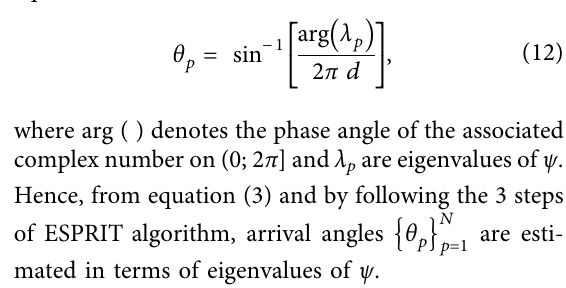
Figure 3: Simplified representation of a typical